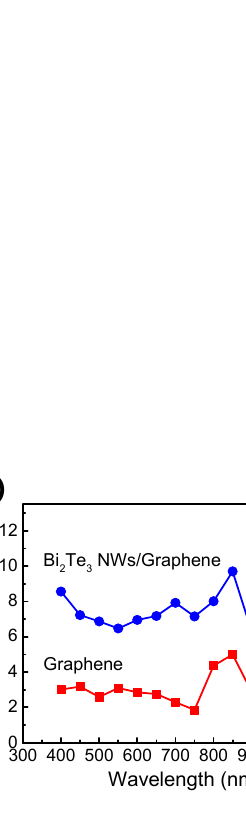
Figure 4. ( a ) Schematic diagram of the generation of an electron (filled circle) and a hole (open circle) under the illuminated condition for the Bi 2 Te 3 NWs/graphene photodetector, ( b ) dark, and ( c ) illuminated status at the Bi 2 Te 3 NWs/graphene junction.